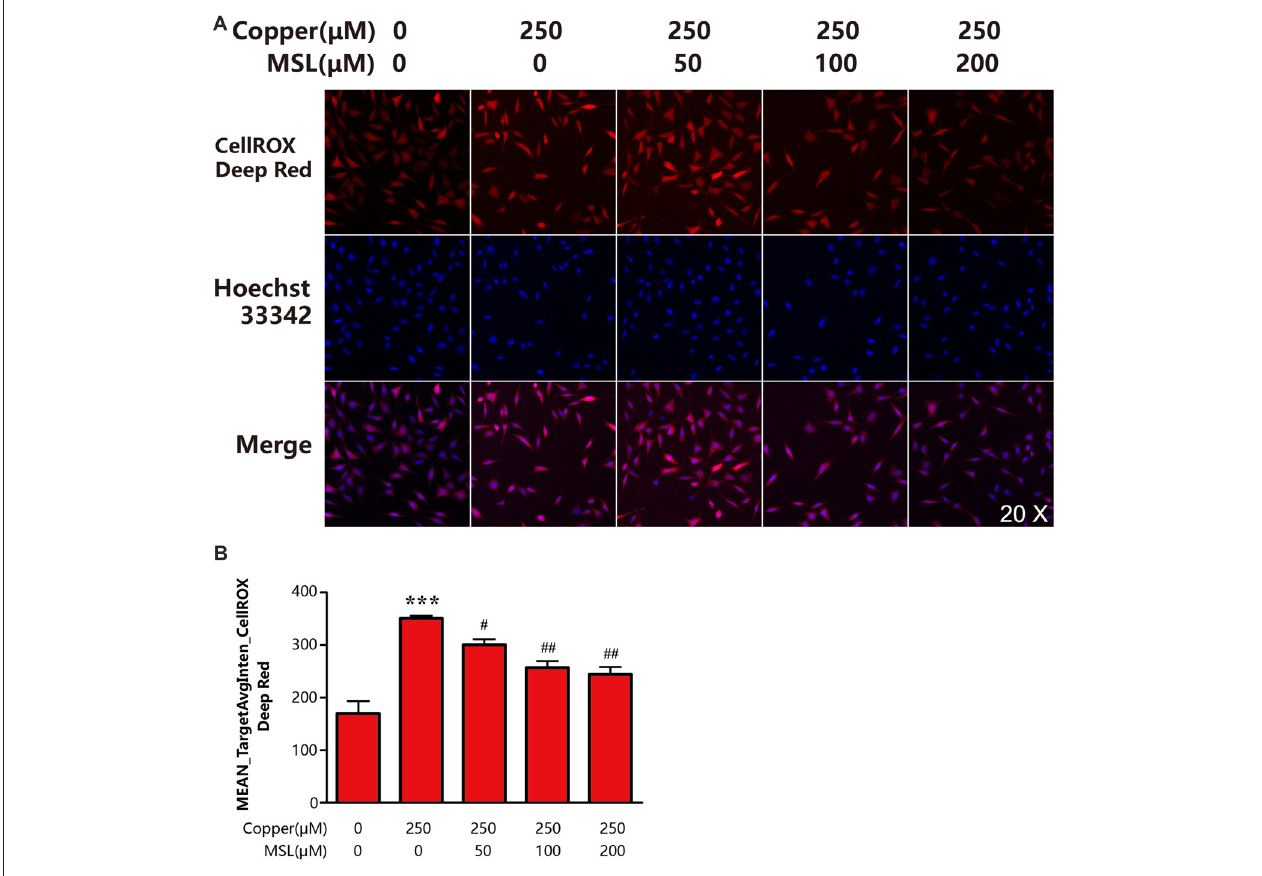
FIGURE 5 | MSL inhibited the production of intracellular reactive oxygen species (ROS) in APPsw cells. (A) Fluorescent images of CellROX Deep Red representing ROS production. Fluorescent images and intensities were analyzed by a Cellomics ArrayScan high-content screening (HCS) Reader and software. (B) Quantified values of CellROX Deep Red was analyzed by Mean_Avginten. Data are expressed as the mean ± SEM, n = 6, ∗∗∗ p < 0.001 vs. untreated cells; # p < 0.05, ## p < 0.01 vs. copper-treated